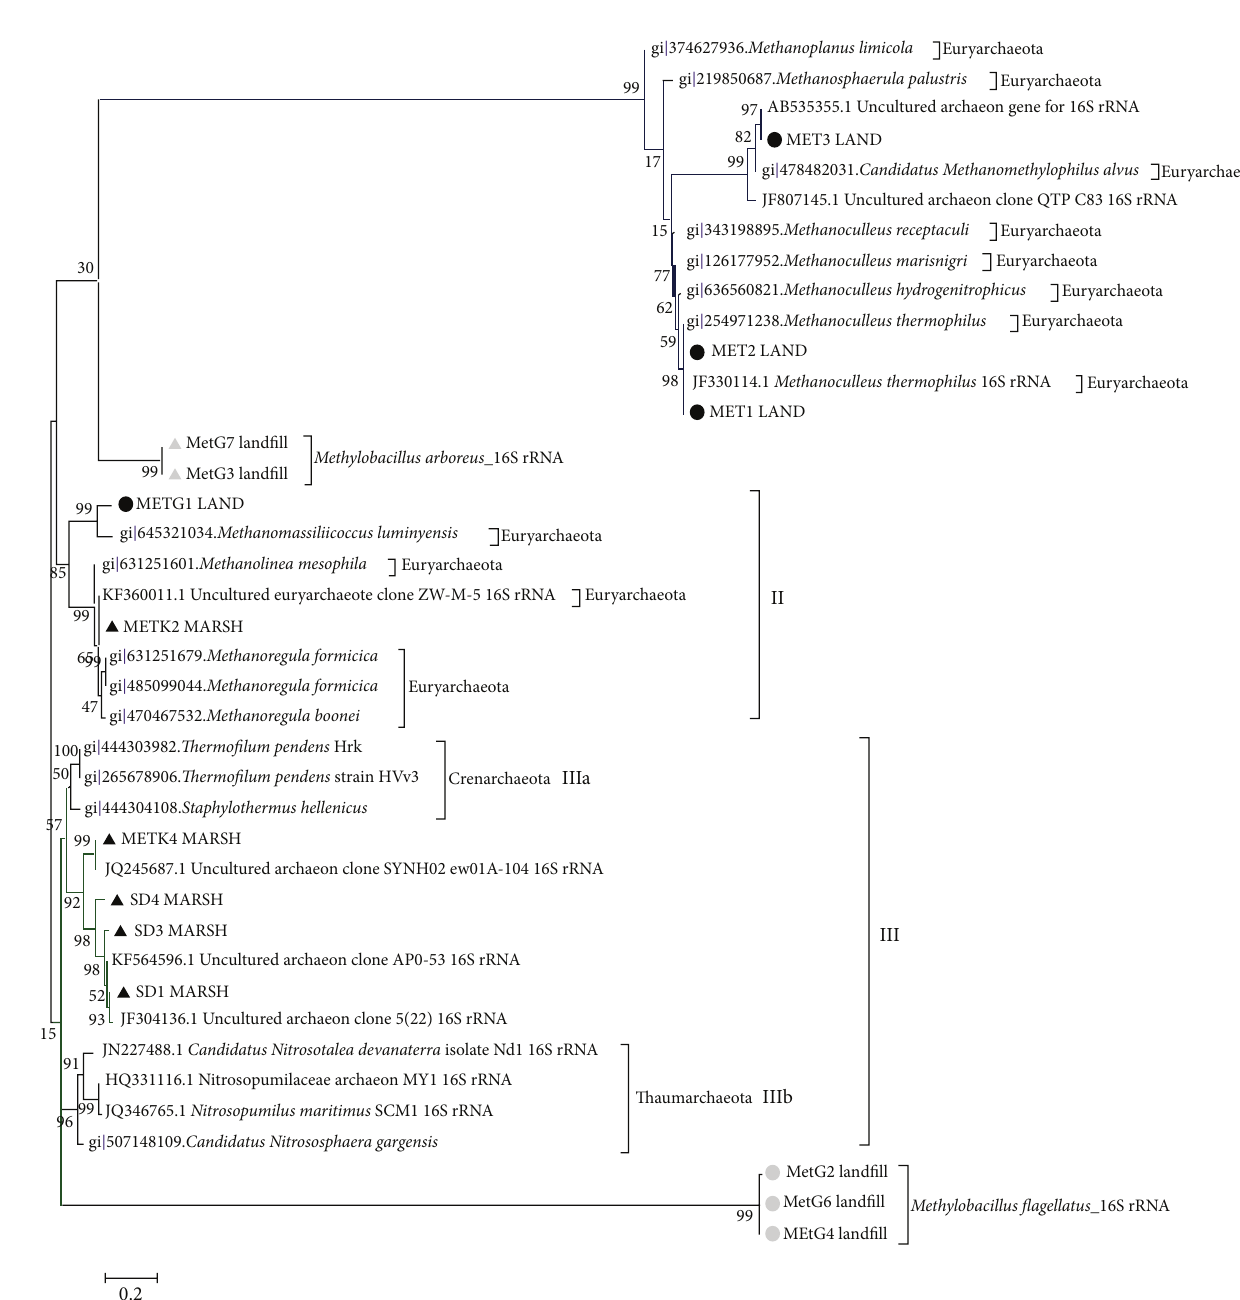
Figure 1: The phylogenetic relationship of 40 partial 16S rDNA sequences (the confirmed 14 sequences of clones are generated in this study, recovered from both Delhi landfills (marked with black circle, grey circle, and grey triangle) and Southern Assam marshland sites (marked with black triangle)) was inferred by the ML method using K2P+G parameter model with 2000 bootstrap replicates using the MEGA 6 tree building